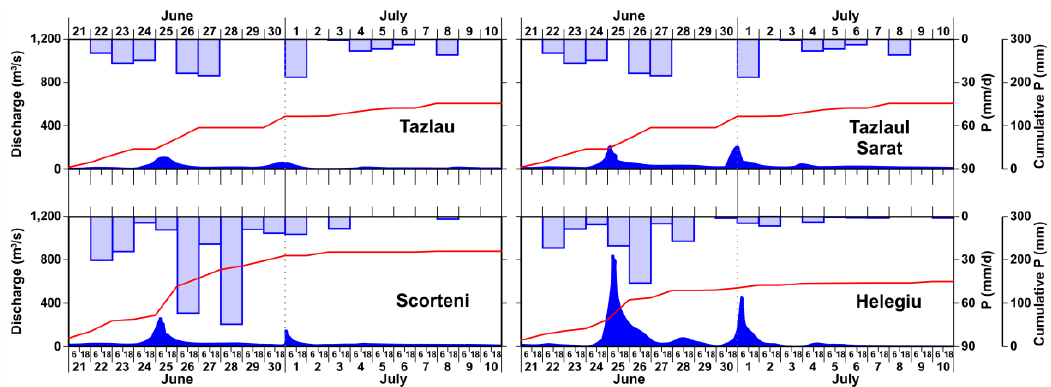
Figure 9. Hydrograph of flood waves and the daily intensity of precipitation between 21 June and 10 July 2010 recorded at the hydrometric stations on the Tazlau River. Table 2. Maximum levels and discharges of Trotus and of its tributaries during the floods of the summer of the year 2010.